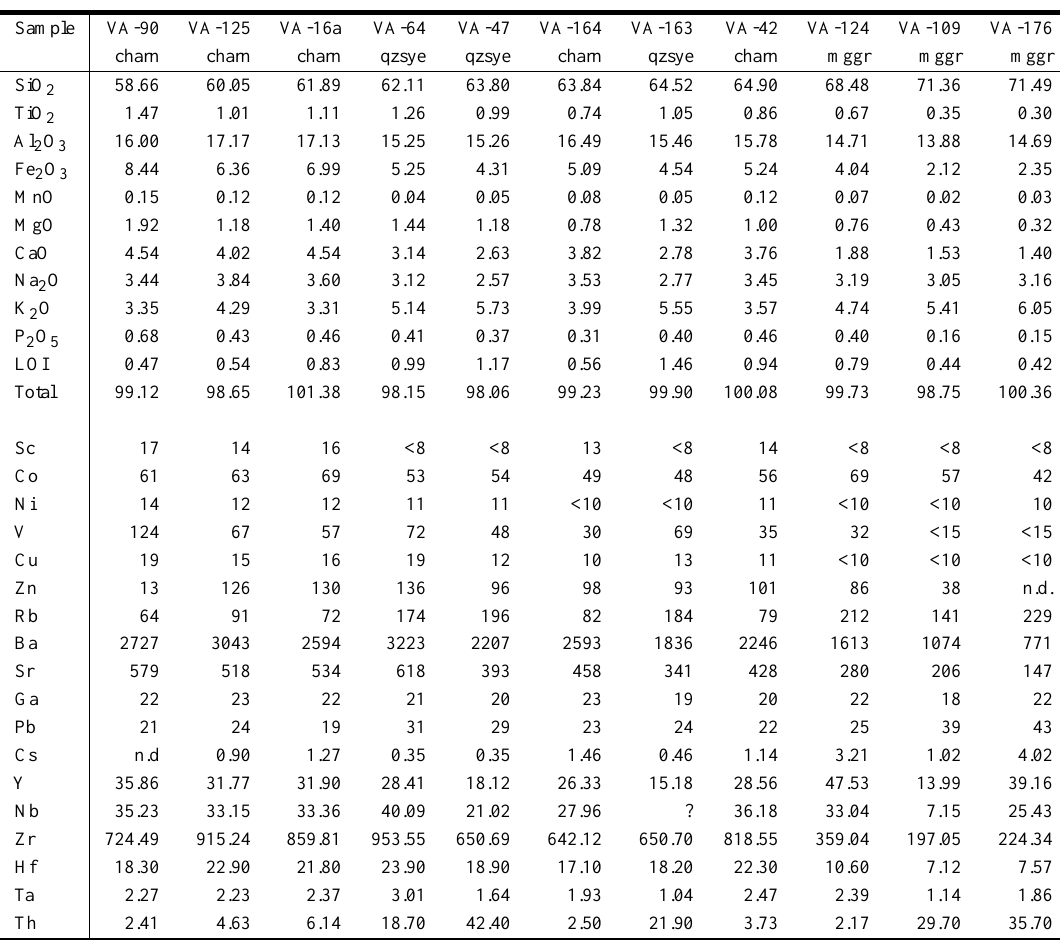
Chemical compositions of charnoenderbitic (charn) rocks, qtz-syenite (qzsye) and megaporphyritic gran- ite (mggr) from Várzea